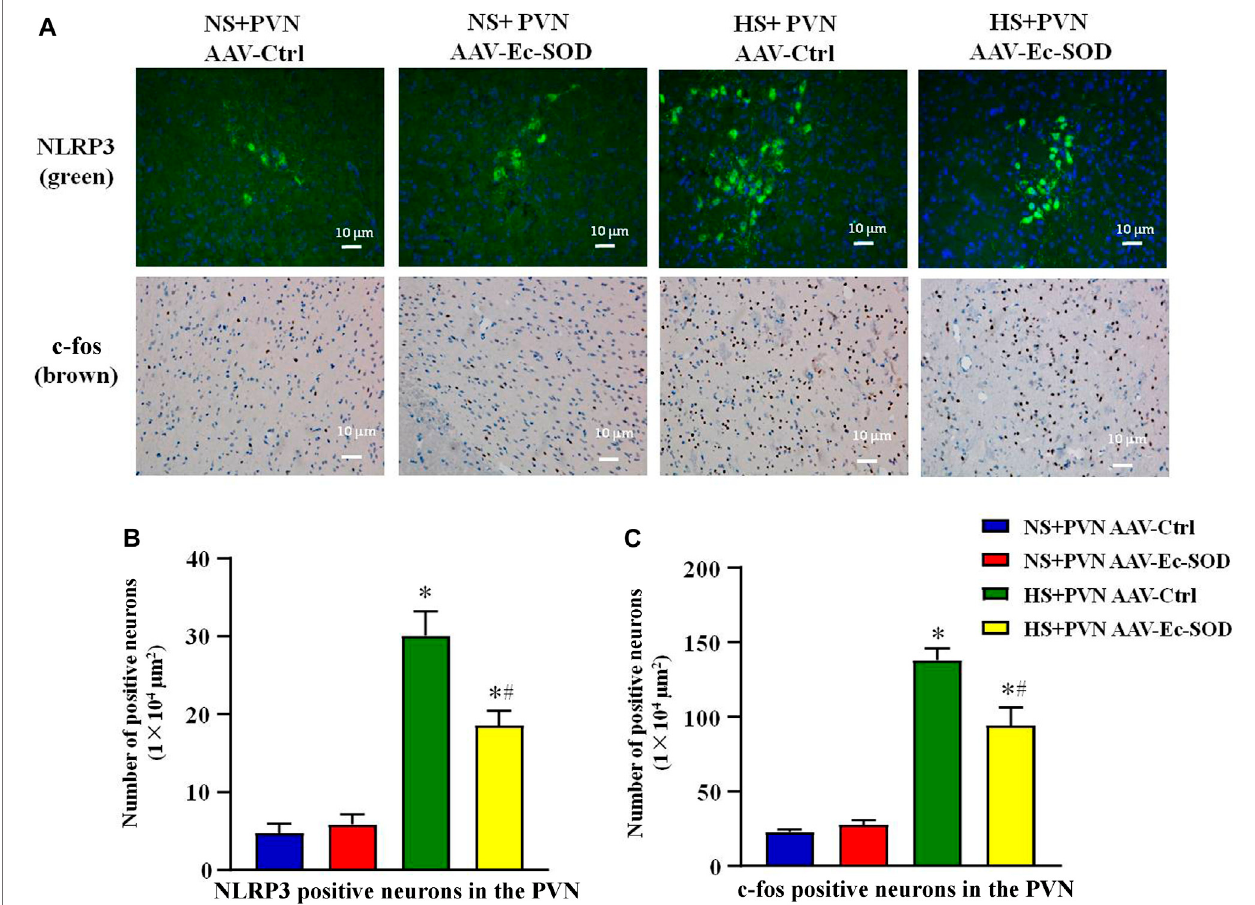
FIGURE 3 | Effect of AAV-Ec-SOD on NLRP3 and c-fos-positive neurons in the PVN. (A) Immuno fl uorescence for NLRP3 and immunohistochemistry for c-fos positive neurons in the PVN in different groups. (B – C) Column diagram showing the NLRP3 and c-fos on positive neurons in the PVN in different groups. Values are expressed as mean ± SEM (n (cid:2) 6). * p < 0.05 NS + PVN AAV-Ctrl vs. HS + PVN AAV-Ec-SOD; # p < 0.05 HS + PVN AAV-Ctrl vs. HS + PVN AAV-Ec-SOD.